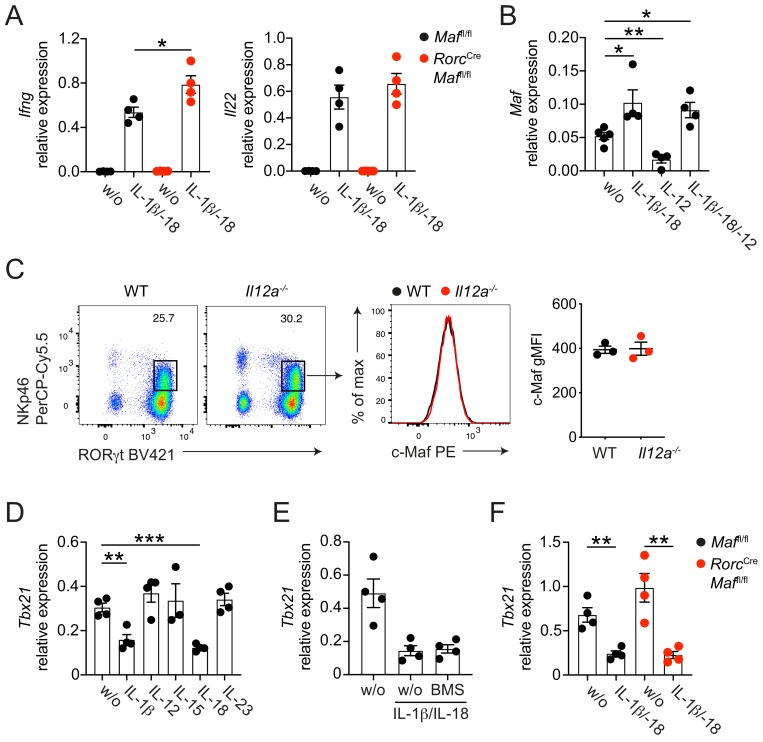
Cytokine-mediated regulation of c-Maf and T-bet expression.(A) Sort-purified siLP NKp46+ CCR6- ILC3s from RorcCre
Maffl/fl or control mice were cultured in vitro for 36 hr in the presence of IL-7/SCF (w/o) or IL-7/SCF plus IL-1ß and IL-18. Subsequently, Ifng and Il22 expression was measured by qPCR (n = 4, mean ± SEM, *p<0.05). (B) Sort-purified siLP NKp46+ CCR6- ILC3s from RorcCre
R26EYFP mice were cultured in vitro for 36 hr in the presence of IL-7/SCF (w/o) or IL-7/SCF plus indicated cytokines. Subsequently, Maf expression was measured by qPCR (n = 4, mean ± SEM, *p<0.05, **p<0.01). (C) Protein expression of c-Maf by siLP NKp46+ ILC3s isolated from Il12a-/- or wild-type mice as measured by flow cytometry (pregated on viable Lin- CD127+ cells). Representative flow cytometric profiles of RORγt vs. NKp46 expression (left); representative histograms showing c-Maf expression (middle); right, quantification of c-Maf gMFI (n = 3, mean ± SEM). (D–E) Sort-purified siLP NKp46+ CCR6- ILC3s from RorcCre
R26EYFP mice were cultured in vitro for 36 hr in the presence of IL-7/SCF (w/o) or IL-7/SCF plus indicated cytokines. Subsequently, Tbx21 expression was measured by qPCR (n = 4, mean ± SEM, **p<0.01, ***p<0.001). The NF-κb inhibitor BMS-345541 (BMS) was added at 1 μM to the culture. (F) Sort-purified siLP NKp46+ CCR6- ILC3s from RorcCre
Maffl/fl or control mice were cultured in vitro for 36 hr in the presence of IL-7/SCF (w/o) or IL-7/SCF plus IL-1ß and IL-18. Subsequently, Tbx21 expression was measured by qPCR (n = 4, mean ± SEM, **p<0.01). All in vitro data are pooled from two independent experiments each with two replicate wells.